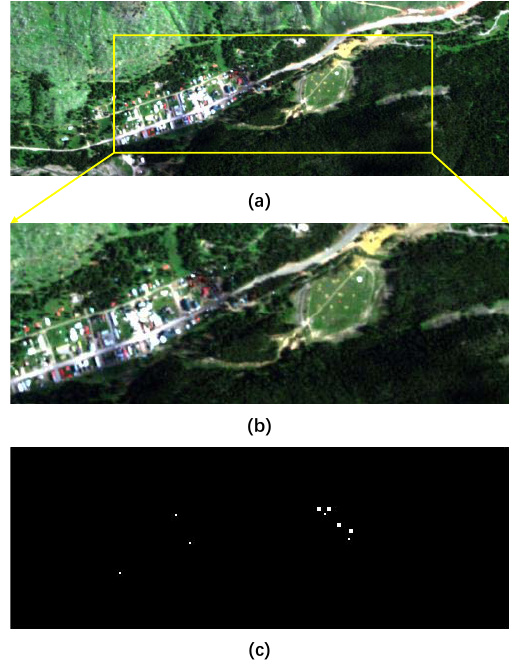
Figure 8. Hyperspectral dataset provided by the Target Detection Blind Test project. ( a ) Whole dataset; ( b ) Smaller subset of the scene; ( c ) Ground truth for the anomaly targets.